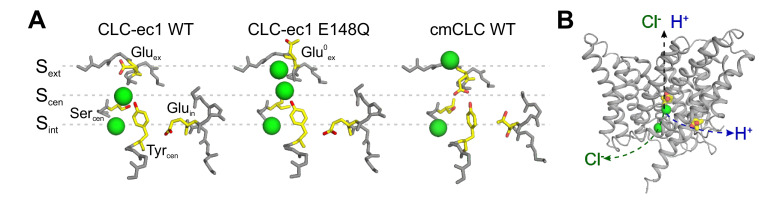
The anion pathway of the CLC Cl-/H+ exchangers.(A) Close up view of the Cl- permeation pathway in three configurations: left, Gluex bound to Sext (CLC-ec1 WT; PDBID: 1OTS); center, protonated Gluex (mimicked by E148Q mutation) reaching out of the ion pathway (PDBID: 1OTU); right, Gluex bound to Scen (cmCLC WT, PDBID: 3ORG). Selected residues are shown as sticks and Cl- ions as green spheres. (B) The partially congruent Cl- and H+ pathways are shown in CLC-ec1 WT structure (Gluex and Gluin are shown in yellow, Cl- ions as green spheres).